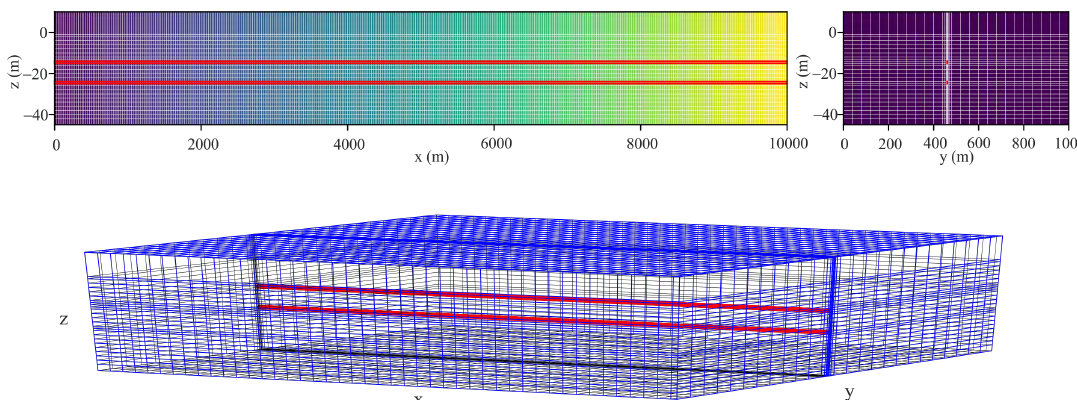
Figure 4. Numerical grid cross section. The red lines represent the conduits. The figure was generated using FloPy